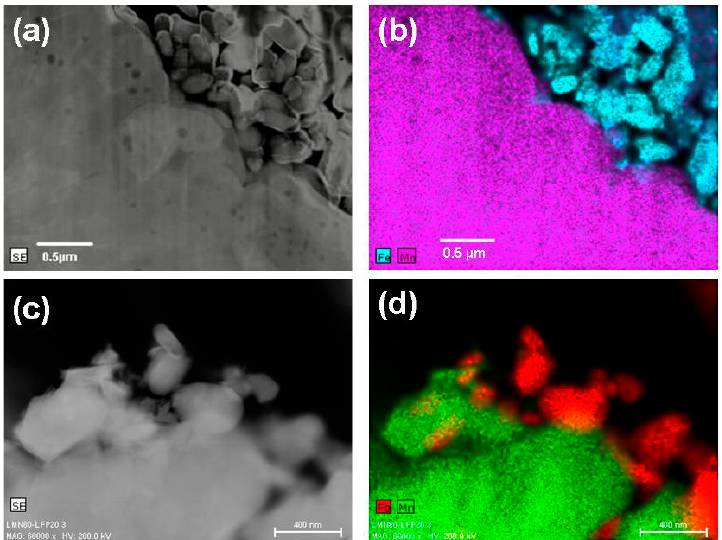
Figure 6. TEM images and EDX maps of NMC–LFP blends with different compositions. ( a , b ) 70:30 (Fe in blue, Mn in violet) and ( c , d ) 80:20 (Fe in red, Mn in green).